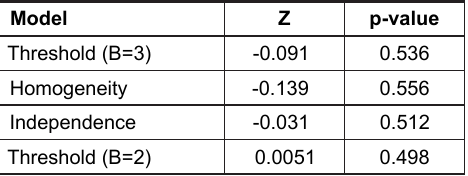
Table 21. Tests for randomness of collars across group sizes for the 2015 Bluenose-West survey.